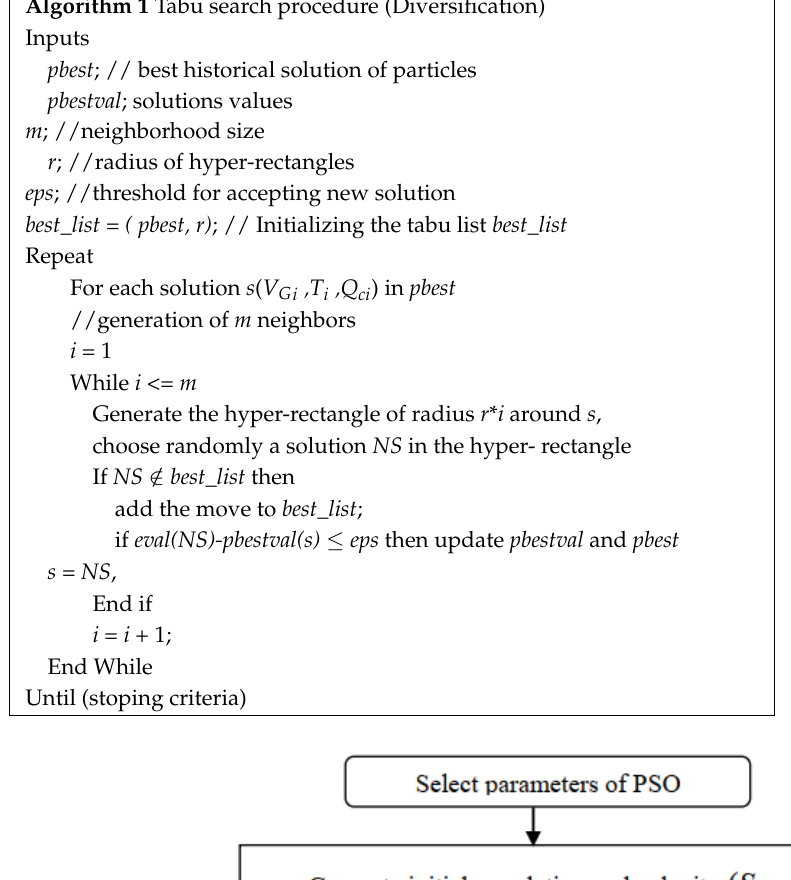
Algorithm 1 Tabu search procedure (Diversification)